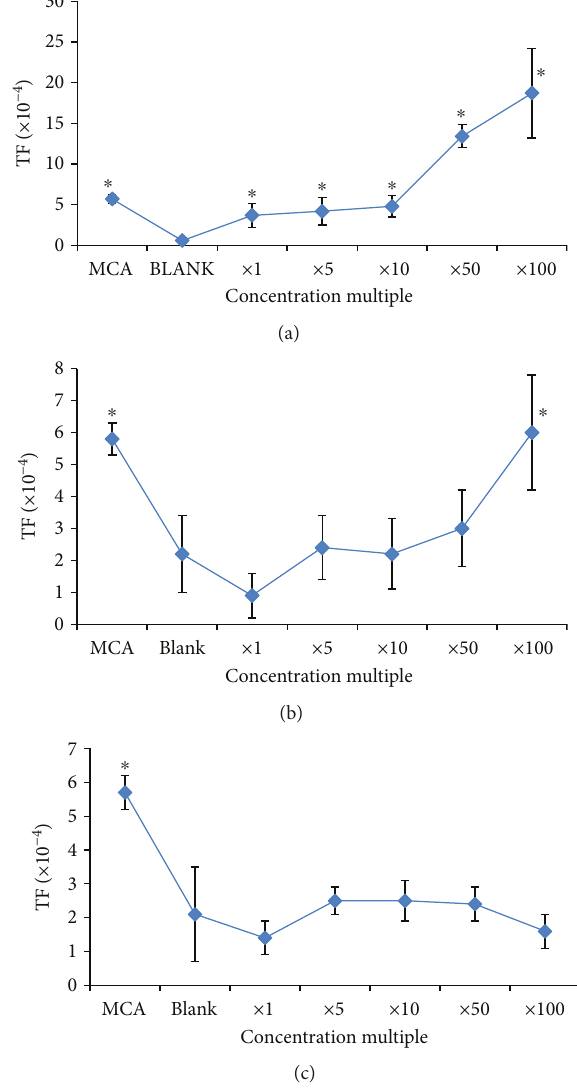
Figure 1: Cell transformation frequency of Balb/c 3T3 cells with di ff erent concentration multiples of di ff erent water samples. (a) River water sample; (b) well water sample from 10-meter depth; (c) well water sample from 40-meter depth. ∗ P < 0 05